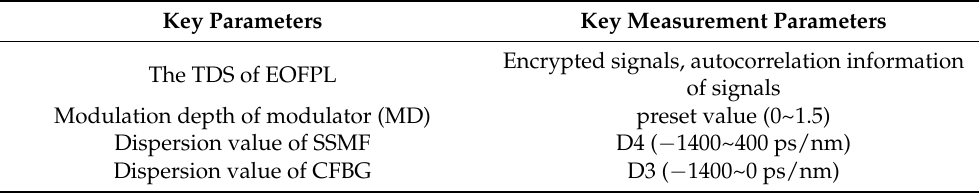
Table 1. Table of key measurement parameters. Key